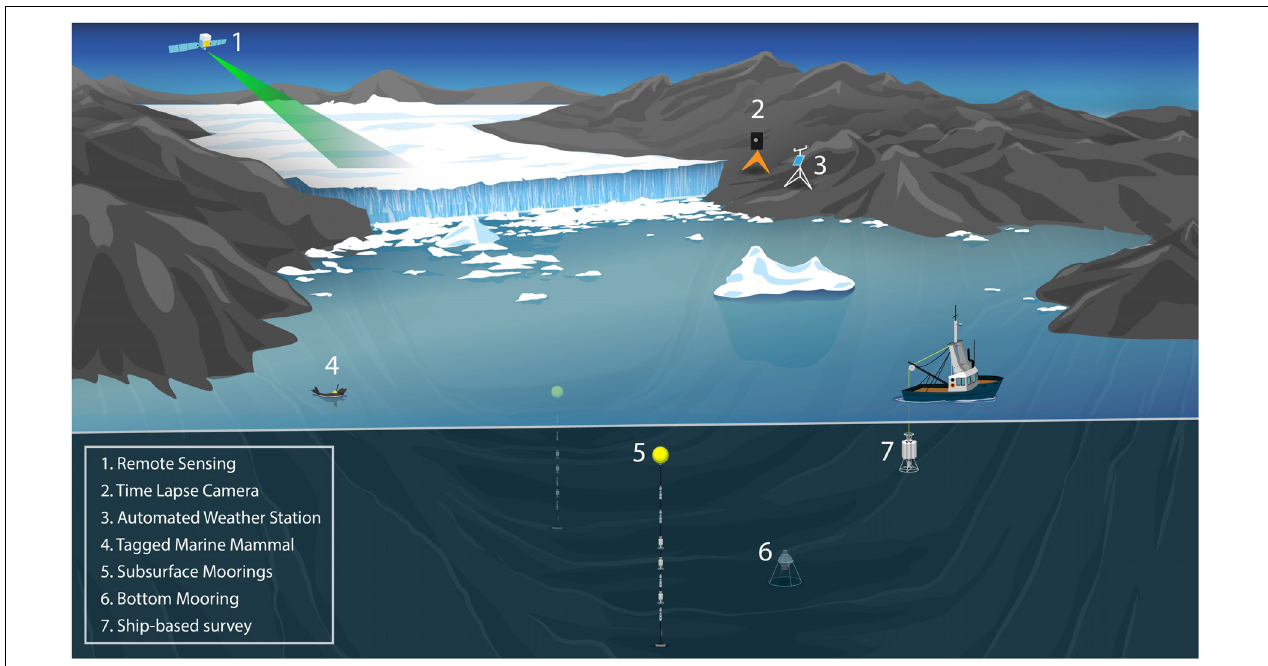
FIGURE 4 | Example of potential instrumentation for a GrIOOS site located at the margins of a tidewater glacier (note: not to